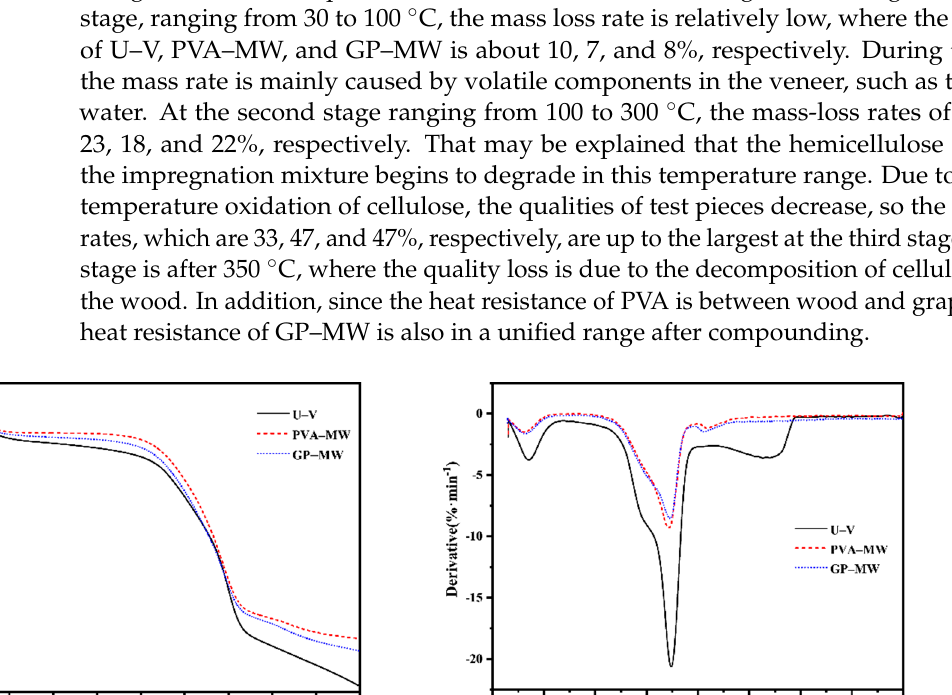
Figure 9. XRD of untreated veneer, PVA, and Gr/PVA impregnated modified veneers.